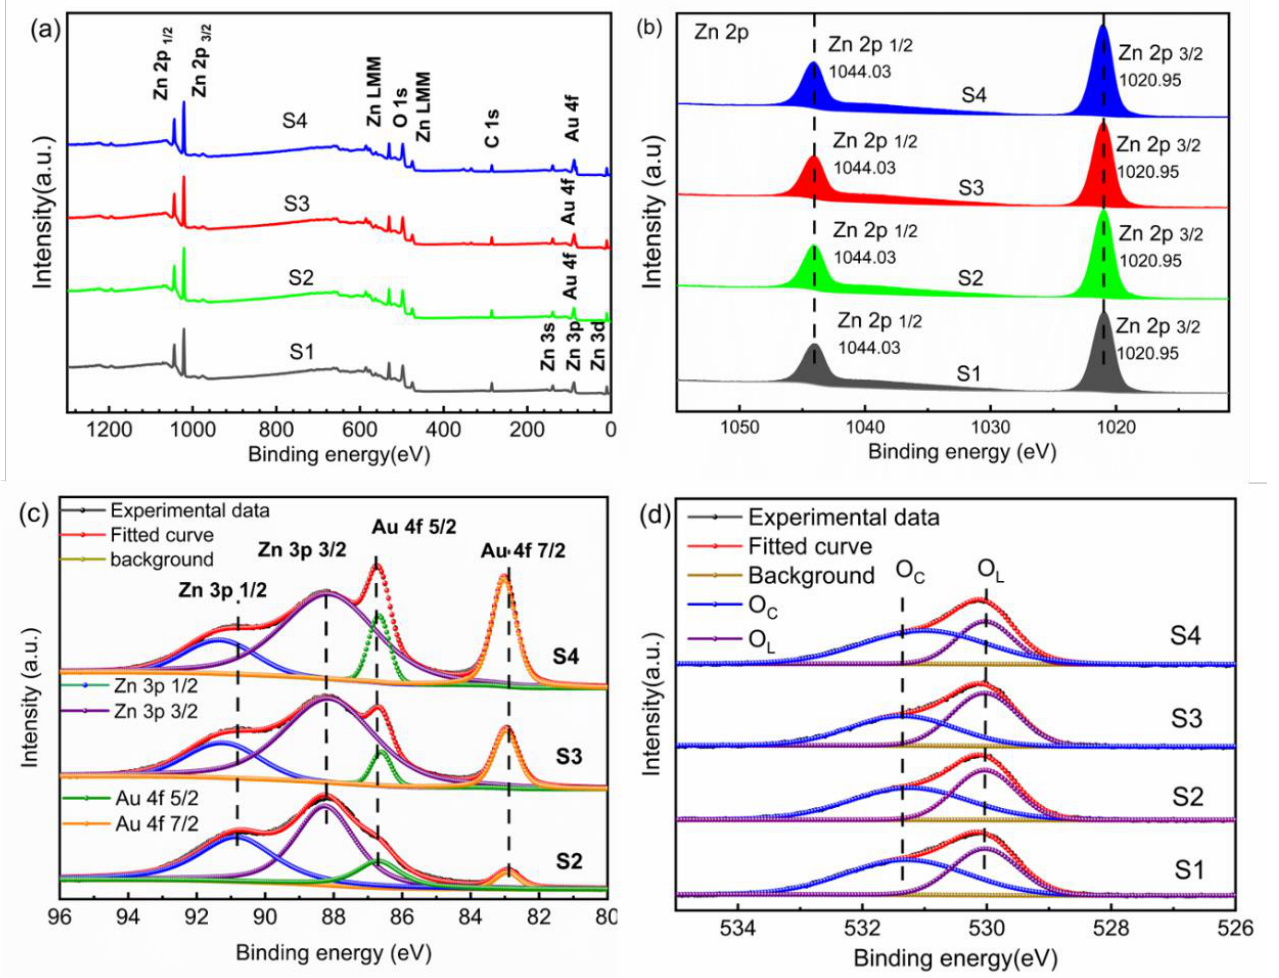
Figure 3. The XPS spectra of pure ZnO and Au@ZnO nanofilms; ( a ) survey; ( b ) Zn 2p; ( c ) Au 4f and Zn 3p; ( d ) O 1s.